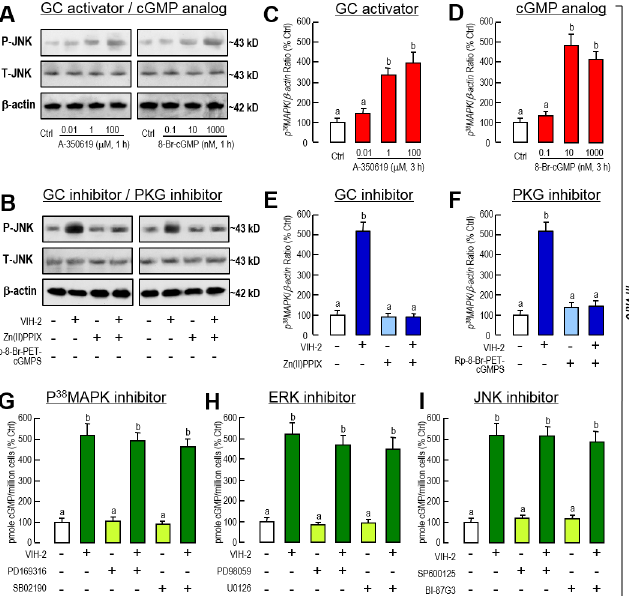
Fig 7. Crosstalk of the GC/cGMP pathway with MAPK-dependent cascades in VIH-2 suppressed Vg mRNA expression in the hepatopancreas of L . vannamei . A: Effects of the GC activator and the cGMP analog on the JNK phosphorylation in shrimp hepatopancreatic cell cultures. The hepatopancreatic cells were incubated for 1 h with increasing doses of A-350619 (0.01–100 μ M) or 8-Br-cGMP (0.1–1000 nM). B: Effects of the GC inhibitor and the PKG inhibitor on the VIH-2-induced JNK phosphorylation in shrimp hepatopancreatic cell cultures. The hepatopancreatic cells were incubated for 1 h with VIH-2 (1 μ M) in the presence or absence of Zn(II)PPIX (5 μ M) or Rp-8-Br-PET-cGMPS (5 μ M). C & D: Effects of GC activator (C) and cGMP analog (D) on the P 38 MAPK mRNA expression in shrimp hepatopancreatic cell cultures. The hepatopancreatic cells were incubated for 3 h with increasing doses of A-350619 (0.01–100 μ M) or 8-Br-cGMP (0.1–1000 nM). E & F: Effects of the GC inhibitor and the PKG inhibitor on the VIH-2 induced P 38 MAPK mRNA expression in shrimp hepatopancreatic cell cultures. The hepatopancreatic cells were incubated for 3 h with VIH-2 (1 μ M) in the presence or absence of Zn(II)PPIX (5 μ M) or Rp-8-Br-PET-cGMPS (5 μ M). G-I: Effects of the P 38 MAPK inhibitor (G), the ERK inhibitor (H) and the JNK